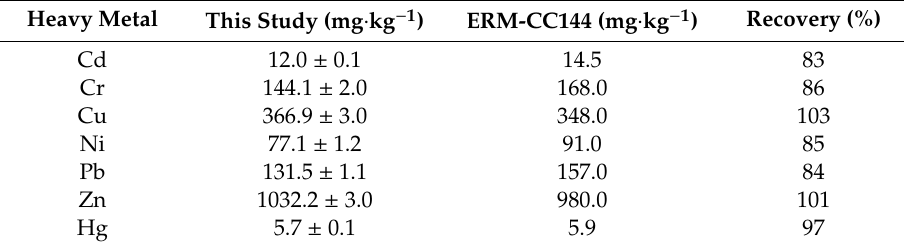
Table 3. Heavy metal concentrations in the certified reference material. Heavy